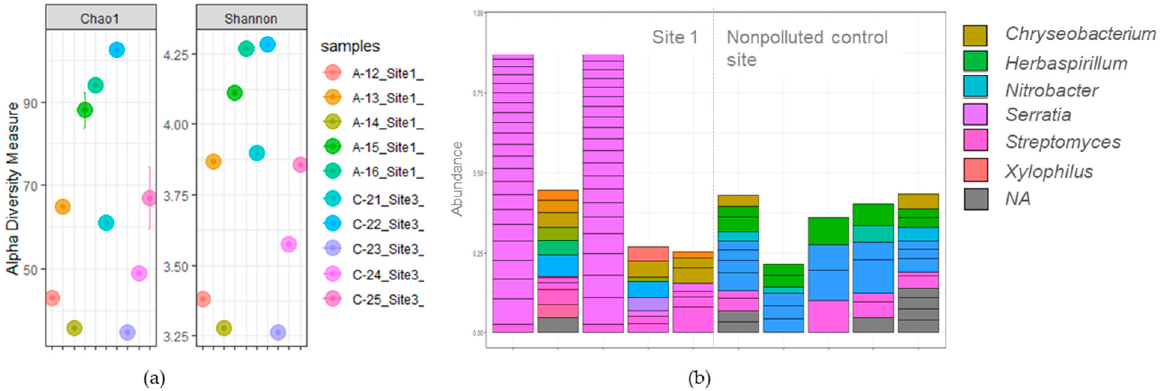
Figure 2. ( a ) Shannon index and Chao diversity analysis of the Illumina Miseq™ reads obtained from the rhizoplane samples of H. petiolaris plants growing on the polluted site 1 and the unpolluted control site 3. Five replicates per site are represented in separate circles. ( b ) The abundance of the most abundant genus-level ASVs from a total of 274 genus-level ASVs detected. Five replicates per site are represented in separate